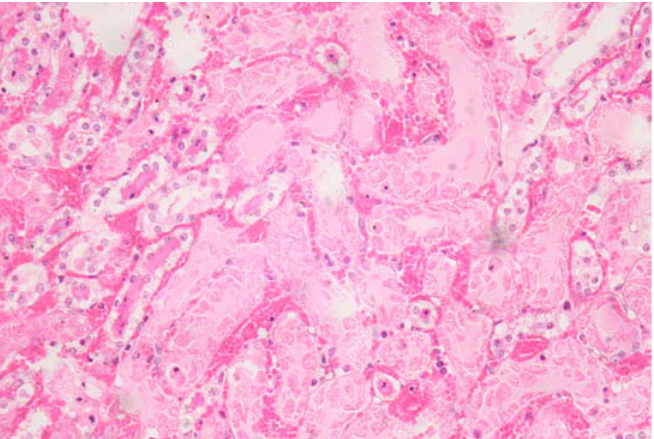
FIGURE 3 - Photomicrography of kidney of rat from the control group (24 h after I/R), showing cell necrosis. Hematoxylin-eosin stained section, magnification 200x